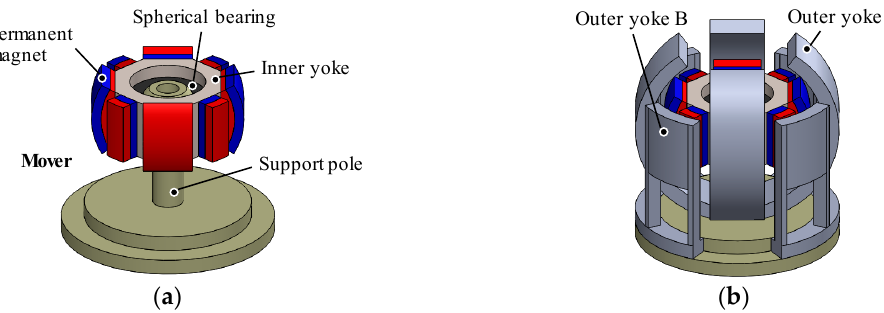
Figure 2. Basic structure. ( a ) Mover and the support parts; ( b ) mover and the stator without the coils.